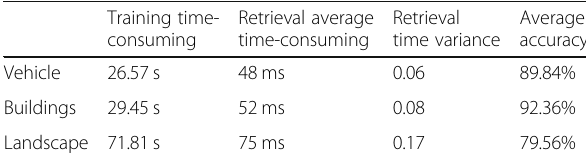
Table 2 Three results of four layers, cubic b-spline wavelet